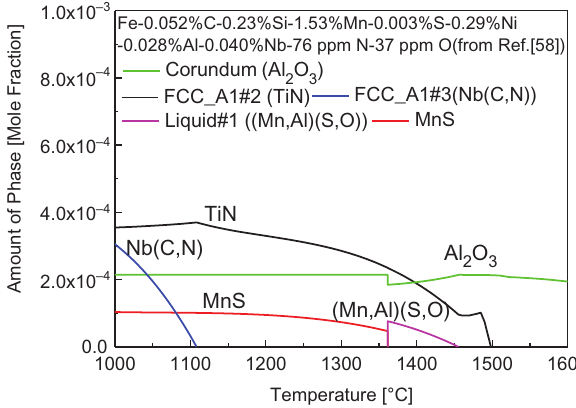
Figure 8: Thermodynamic calculation of inclusion precipitate using the composition of Nb, Ti micro-alloyed steel from Ref. [58].